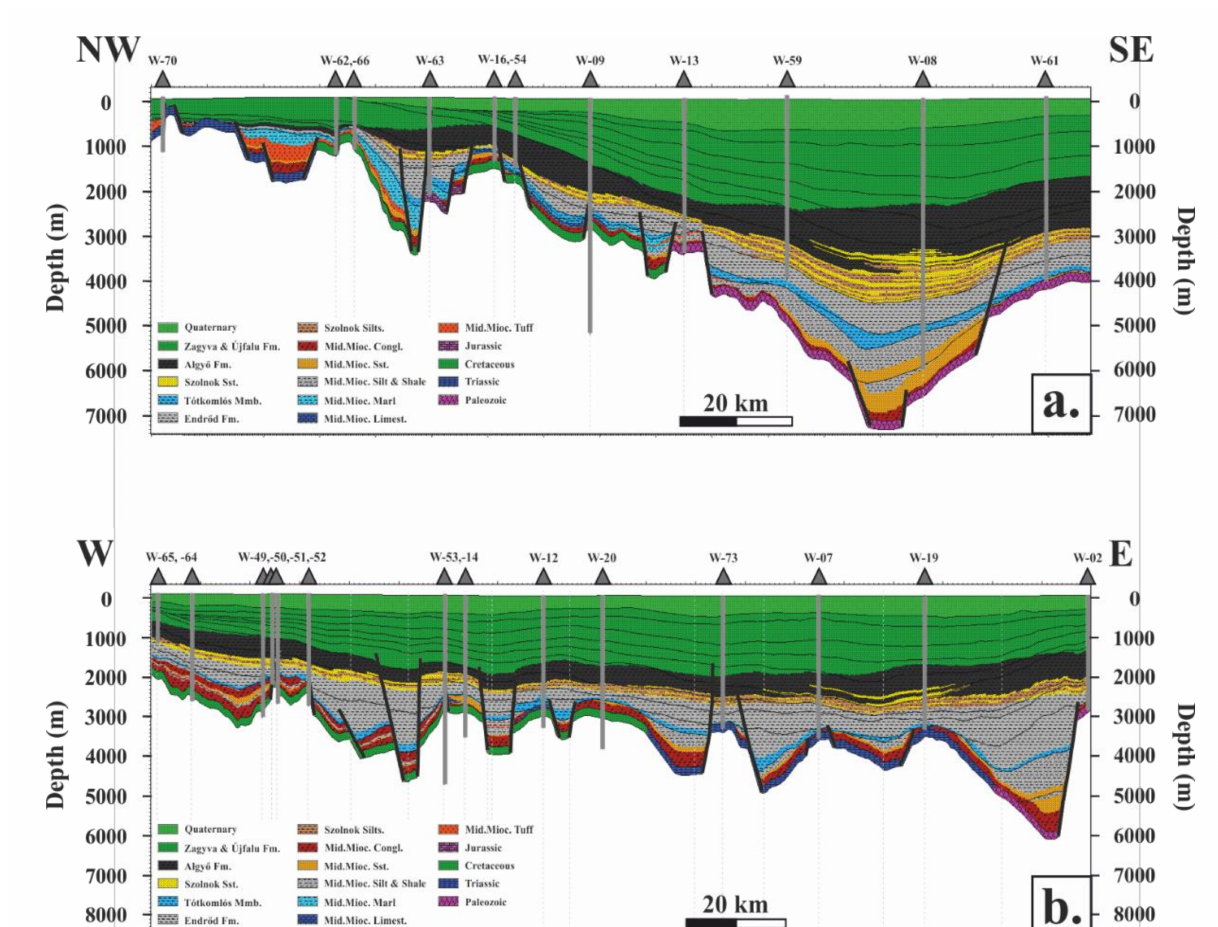
Figure 8. Simulated sections with the chronostratigraphic horizons (black lines) and the lithofacies: ( a ) Section_01 is parallel with the direction of paleo deltas; ( b ) Section_01A is perpendicular to sediment influx. Horizons were converted into 2D models in Schlumberger PetroMod